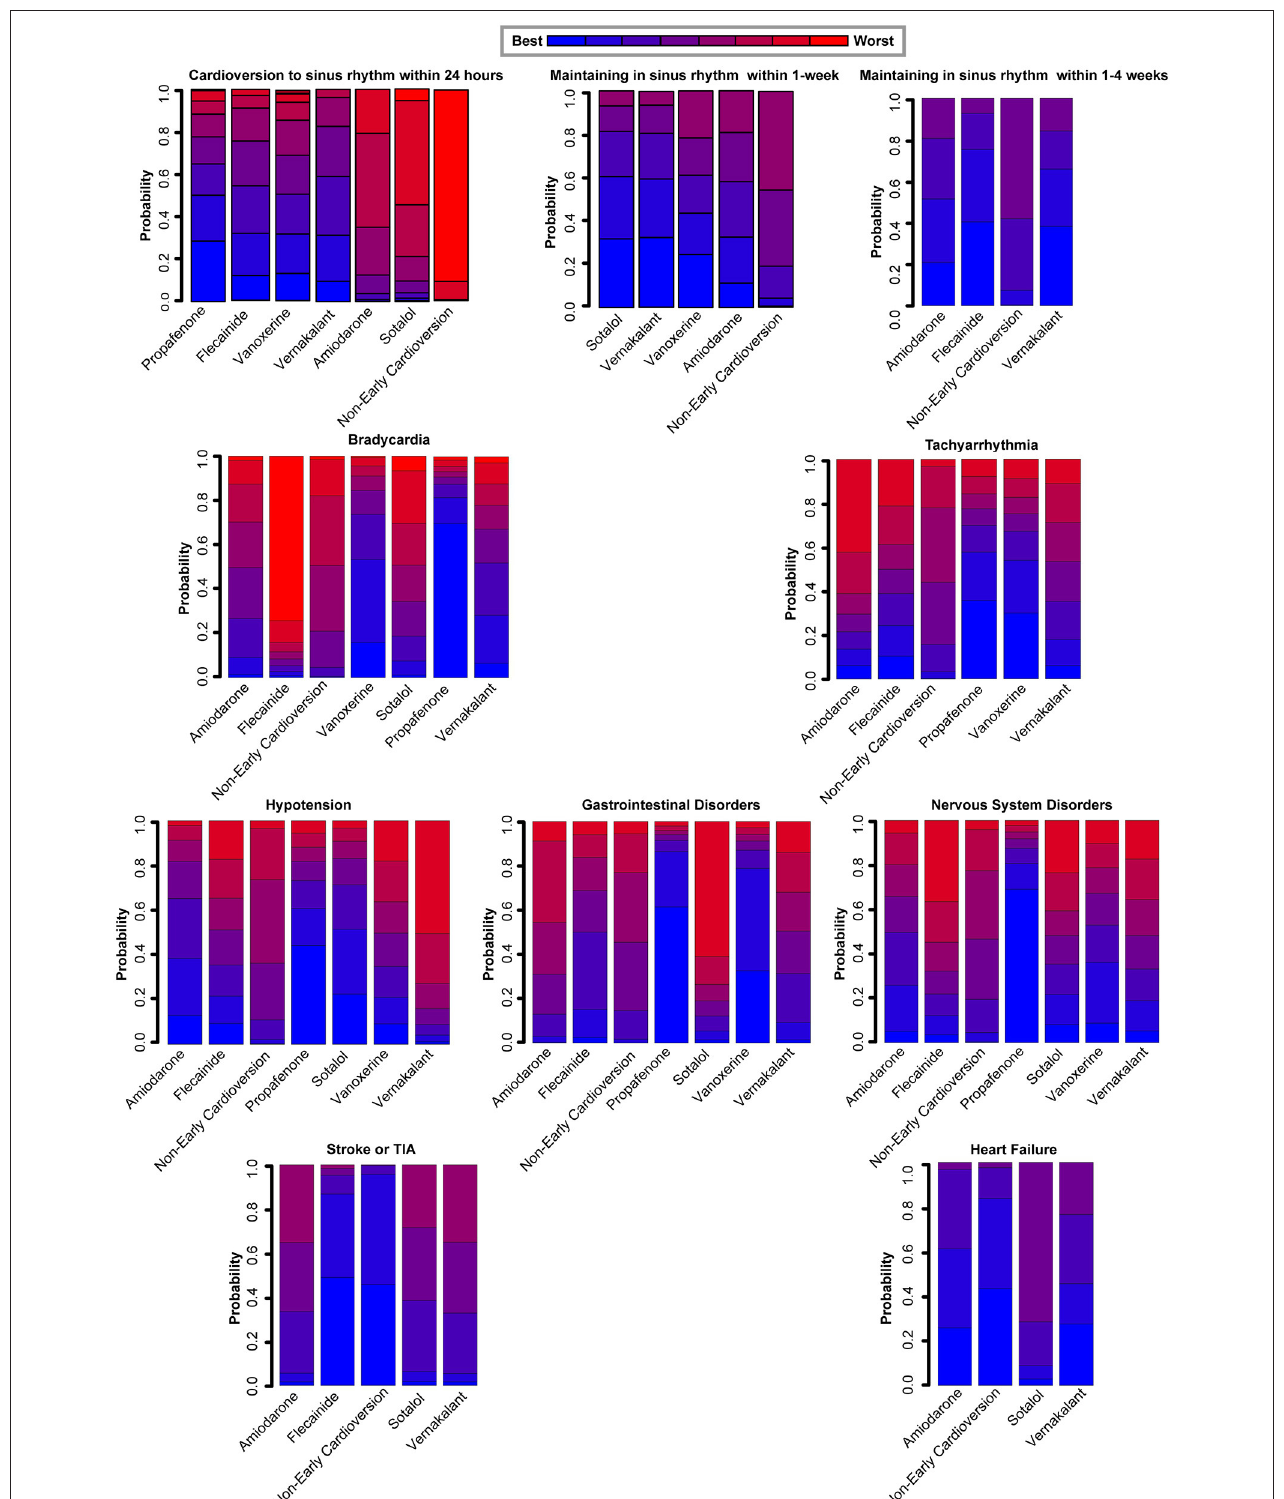
FIGURE 4 | Rankograms demonstrate the probability of each therapy ranked across all endpoints. * The antiarrhythmic drugs as early pharmacologic cardioversion in the study included amiodarone, propafenone, flecainide, vernakalant, vanoxerine, and sotalol. † All endpoints are efficacy endpoints including cardioversion to sinus rhythm within 24h, maintenance in sinus rhythm within 1-week and maintenance in sinus rhythm within 1–4-weeks, safety endpoints including bradycardia, tachyarrhythmia, hypotension, gastrointestinal disorders, and nervous system disorders, and prognostic endpoints including stroke or TIA and heart failure. TIA, Transient Ischemic